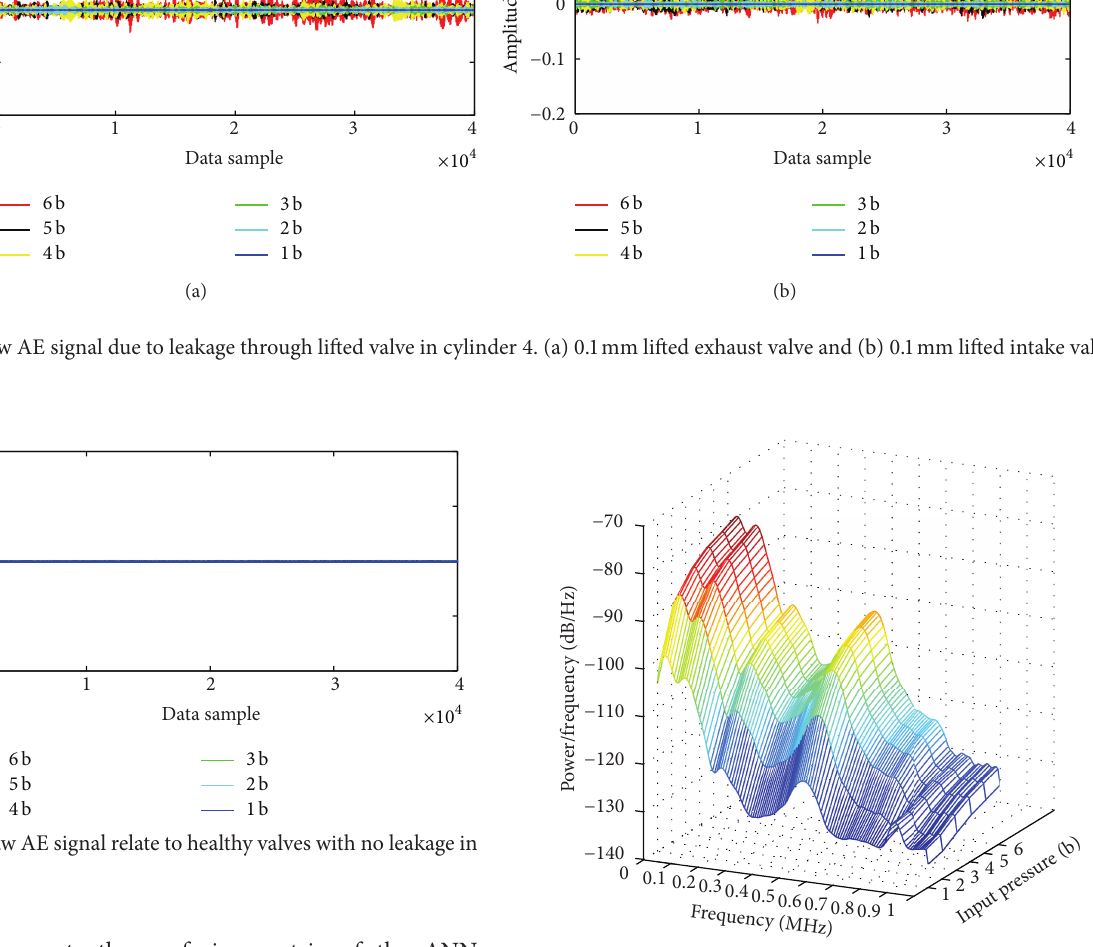
Figure 11: Power spectral density of raw AE signal due to VL through semicracked exhaust valve in cylinder 1 versus time at 1–6 bar by sensor number